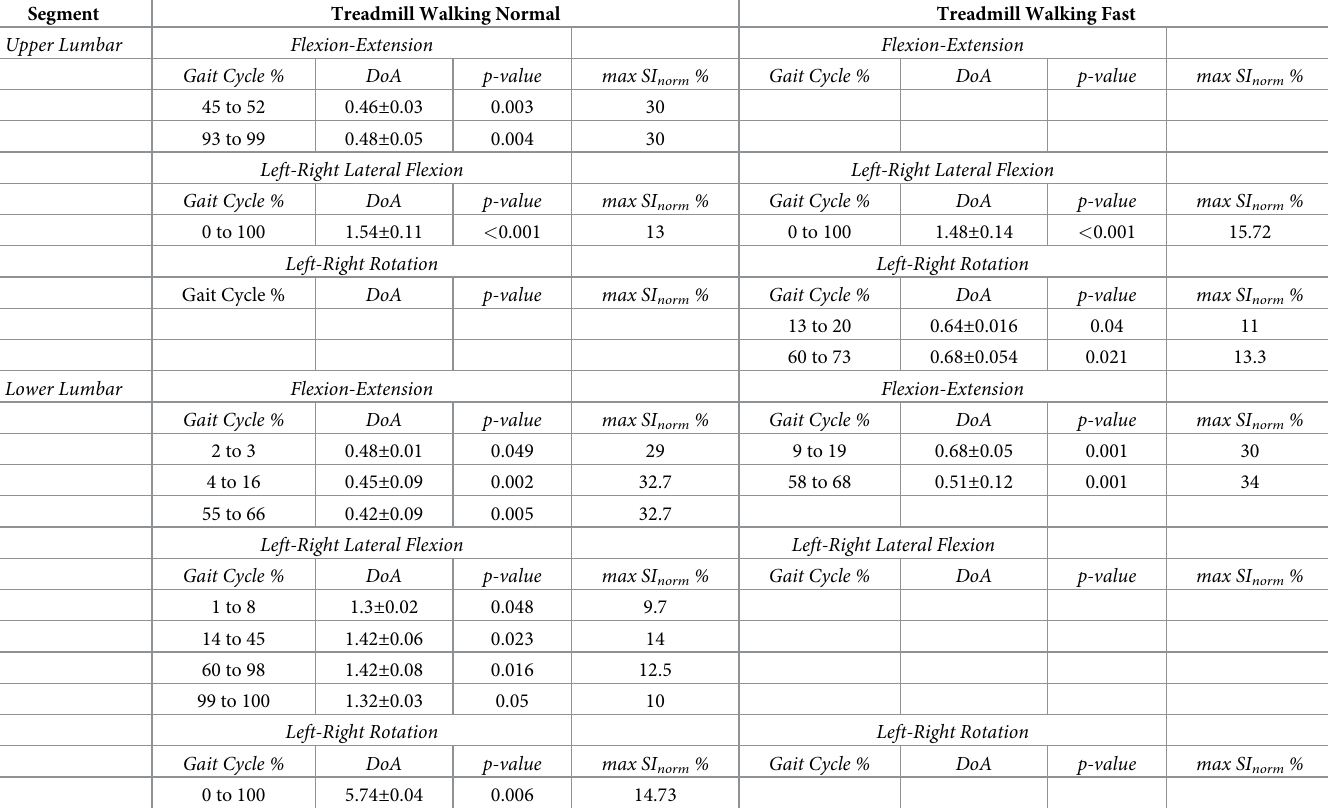
Table 1. Average and standard deviation of the degree of asymmetry and maximum magnitude of the normalized symmetry index between the associated left and right motions in spine segments during normal and fast treadmill walking of N = 60 participants.